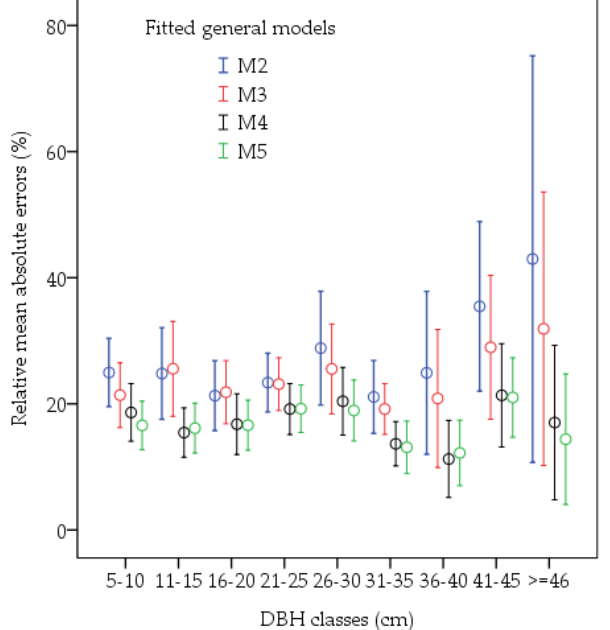
Figure 2. The relationship between relative errors and the classes of diameter at breast height (DBH) indicates the fitness of the general models. The error bar indicates the 95% confidence intervals of the mean.